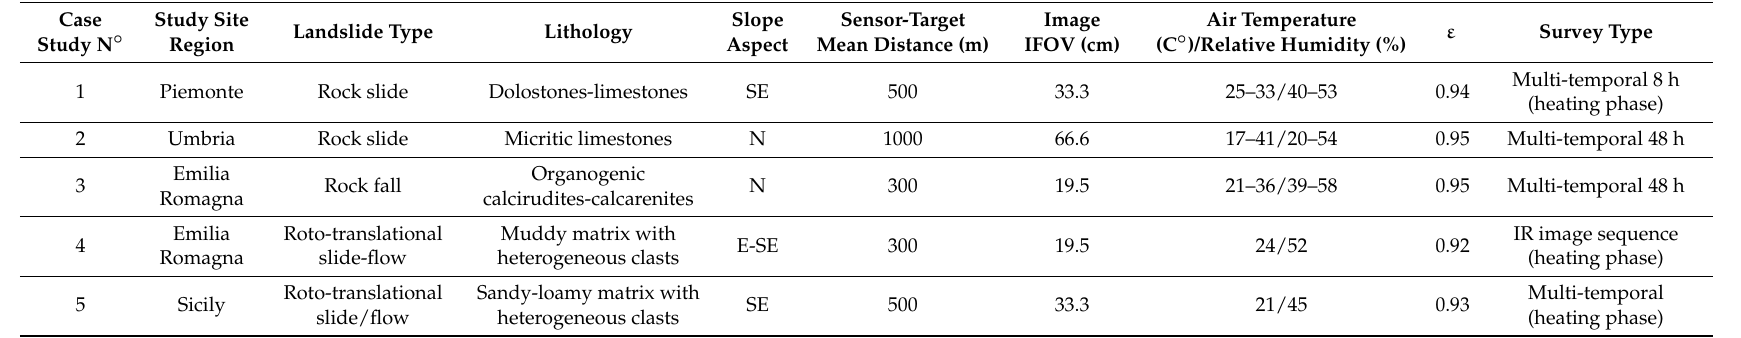
Table 2. Study site and Infrared Thermography (IRT) survey